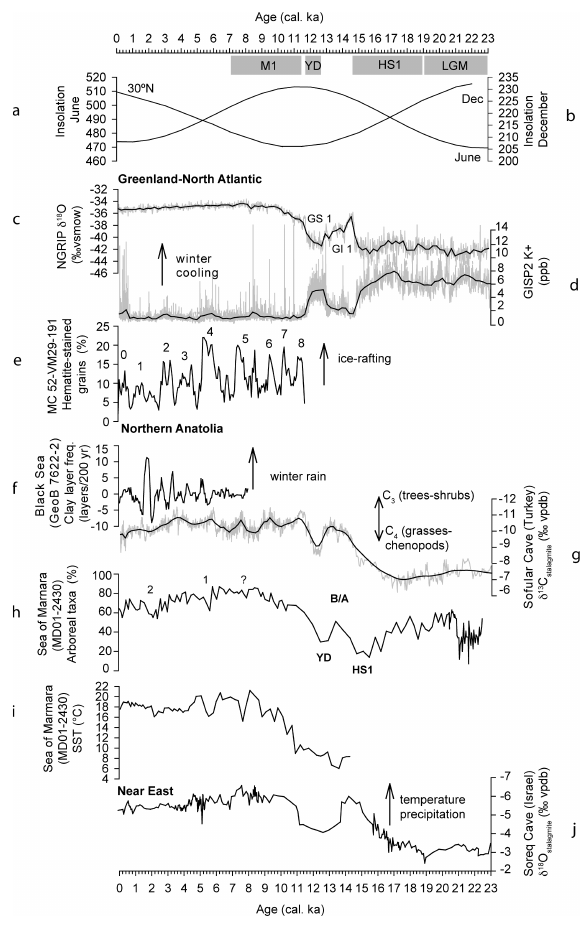
Fig. 5. Selected palaeoclimate records arranged by latitude (north on the top) and palaeoproxies for core MD01-2430. (a) – (b) Sum- mer and winter insolation values at 30 ◦ N (Berger and Loutre, 1991). (c) NGRIP δ 18 O (‰ VSMOW) proxy for temperature based on GICC05 timescale (Andersen et al., 2006; Rasmussen et al., 2006; Vinther et al., 2006), black solid curve represents 200 years (span 0.1) running average smoothing. (d) GIPS2 potassium ion (ppb) proxy for the SH (Mayewski et al., 1997), black solid curve represents 200yr (span 0.01) running average smoothing. (e) Ice-rafted hematite-stained grains in the North Atlantic sediment cores MC52 and VM29-191. Numbers from 0 to 8 designate the millennial-scale cycles (Bond et al., 1997, 2001). (f) Clay layer fre- quency record from core GeoB 7622-2 (Black Sea) proxy for win- ter precipitation in Northern Anatolia (Lamy et al., 2006). (g) δ 13 C (‰ VPDB) of stalagmite So-1 from Sofular Cave (Turkey) proxy for type and density of vegetation: values of − 12‰ are charac- teristic for C 3 plants (trees and shrubs) and values of − 6‰ for C 4 (grasses and chenopods) plants (Fleitmann et al., 2009), black solid curve represents 200yr (span 0.01) running average smooth- ing. (h) Arboreal pollen type (%) including temperate and Mediter- ranean plants for core MD01-2430 (this study), numbers indicates forest set-backs, while labels YD, B/A and HS1 indicate biostrati- graphic zone based on our data. (i) Alkenone derived sea-surface temperatures (SST) on the core MD01-2430 (Vidal et al., 2010). (j) δ 18 O (‰ VPDB) of Soreq Cave (Israel) (Almogi-Labin et al., 2009). Numbers 1 and 2 indicate forest setbacks (h) . For the legend of grey boxes LGM, HS1, YD and M1 see Fig.